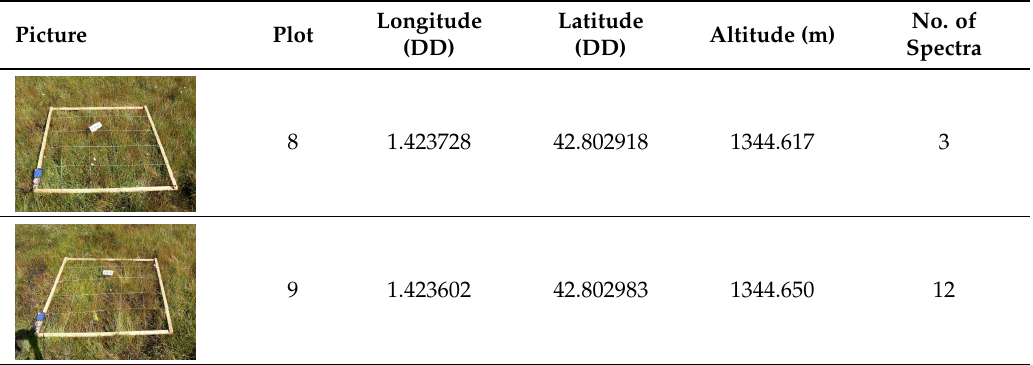
A4. Pictures, plots, geographic coordinates and number of spectra of Eleocharis quinqueflora (ELQU).